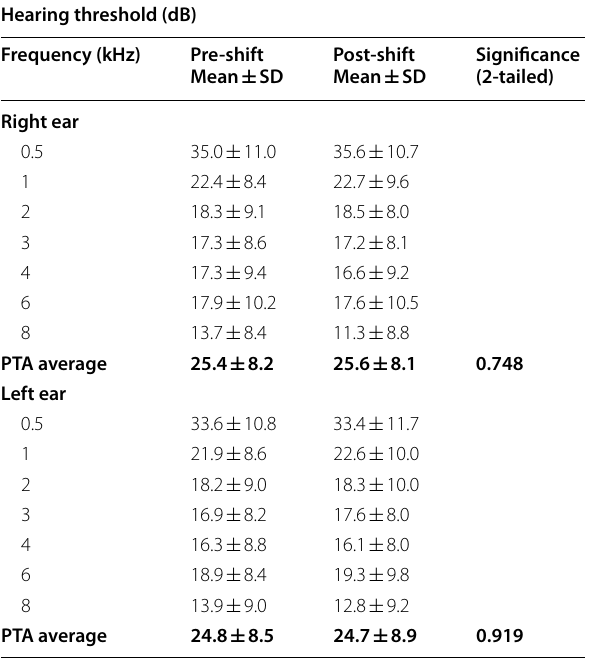
Table 4 Comparison of pre-shift and post-shift